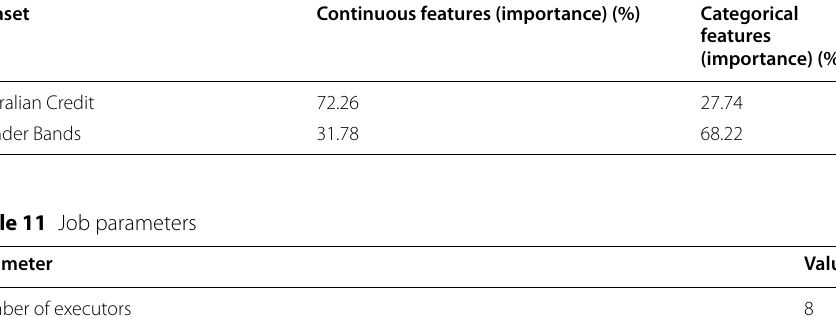
Table 10 Importance assigned by FCMD-MD to each feature type Dataset